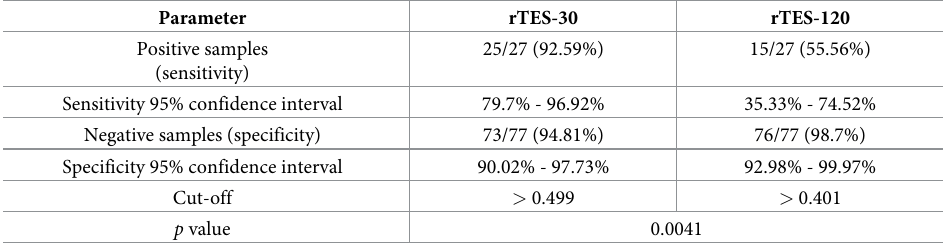
Table 3. ELISA sensitivity and specificity for each recombinant protein as determined by a Receiver Operating Characteristic (ROC) analysis for sheep.